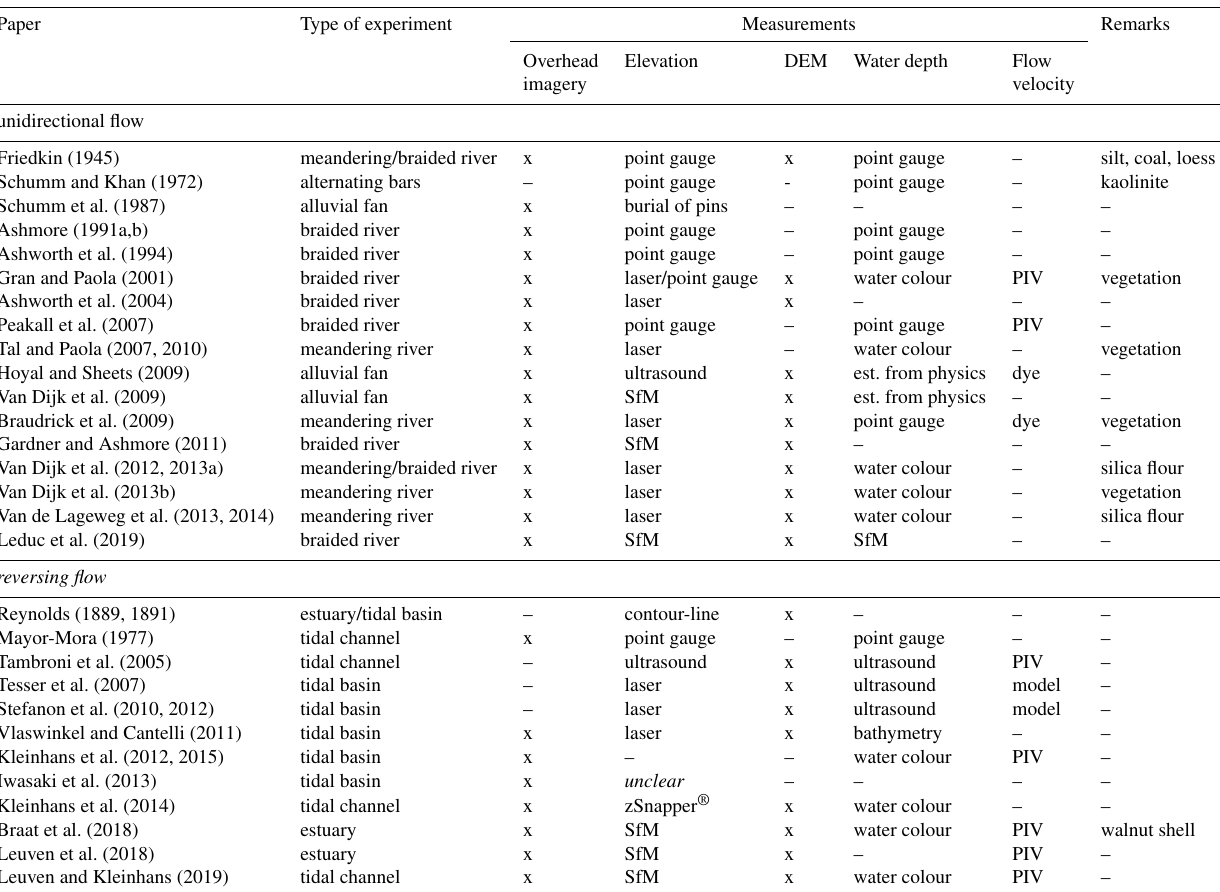
Table 1. Data collection techniques in fluvial and tidal scale experiments with erodible boundaries and flows shallower than a few centimetres. “Overhead imagery” constitutes imagery or video from a camera at a fixed position that potentially allows for the classification of the experiment planform. Water depths “est. from physics” are determined for a few cross sections assuming uniform flow and a given discharge. “SfM” is structure-from-motion photogrammetry. The field “Remarks” contains additional sediments/vegetation on top of the main sediment that may interfere with overhead imagery